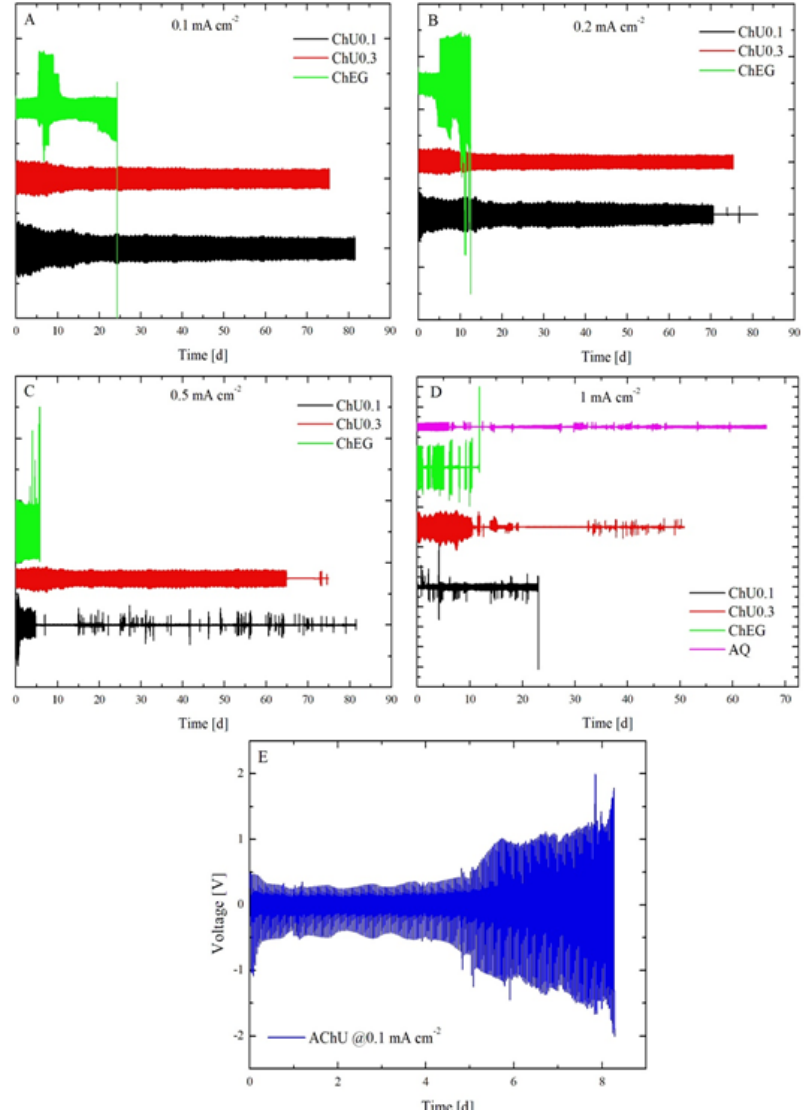
Figure 12. Galvanostatic charge-discharge cycling experiments carried out with Zn symmetric CR2032 coin cells with ChU0.1 (black plot), ChU0.3 (red plot), ChEG (green plot), and ChU electrolytes at 0.1 (Panel ( A )), 0.2 (Panel ( B )), 0.5 (Panel ( C )), 1 (Panel ( D )) and 0.1 mA cm −2 (Panel E ), respectively.